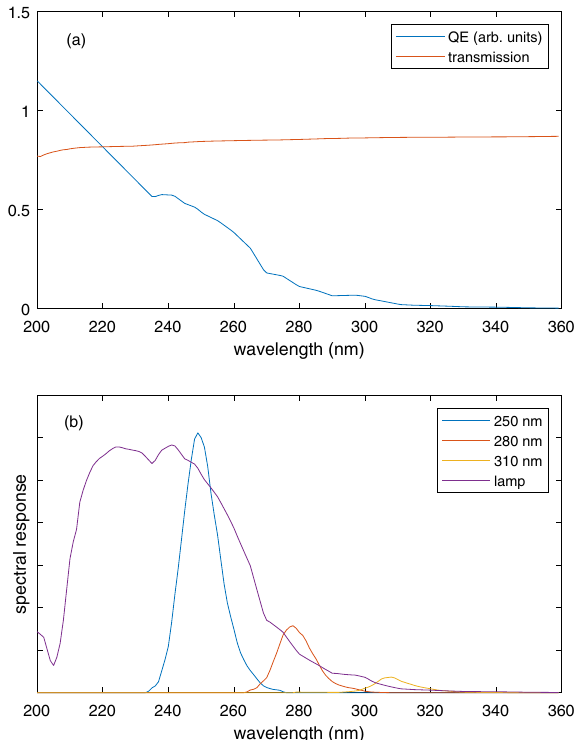
Figure 2. Spectral characteristics of the UV transmission apparatus. Panel ( a ) shows the transmittance and detector quantum efficiency, while ( b ) shows the spectral response of the light source–cuvette–detector system for three LEDs and a deuterium lamp.